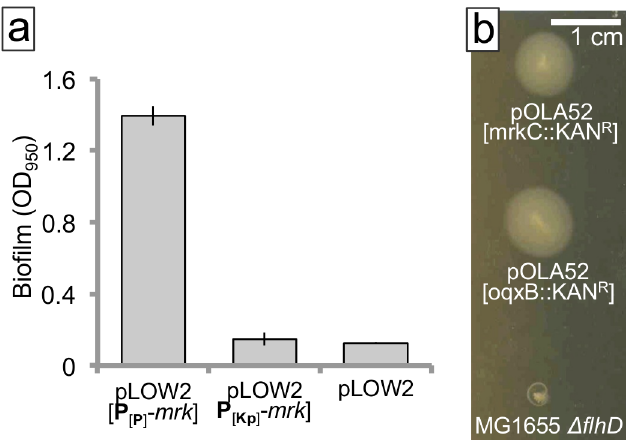
Fig 6. Influence of plasmid encoded mrkABCDF expression on biofilm-formation and motility of E . coli . (a) Biofilm formation by CV staining of attached cells after 24h growth at 37°C in microtitre plate wells. P mrkA [P] - mrkABCDF made more biofilm than both P mrkA [Kp] - mrkABCDF and the control: pLOW2 without mrkABCDF . (Error bars denote ± SEM, n = 3). (b) Swimming motility assay performed in 1% tryptone medium with 0.3% agar at 37°C. Negative controls (MG1655 Δ flhD ) confirm the applicability of the assay.